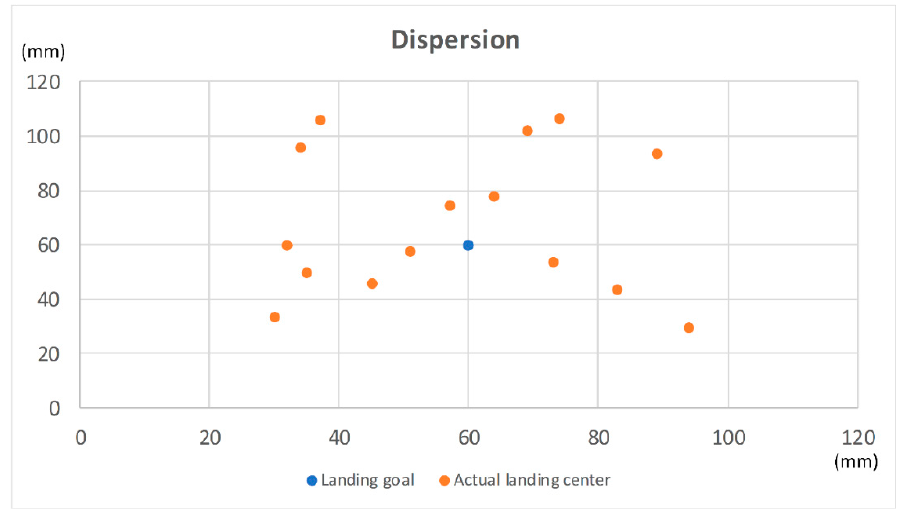
Figure 23. Actual landing spot versus landing goal.